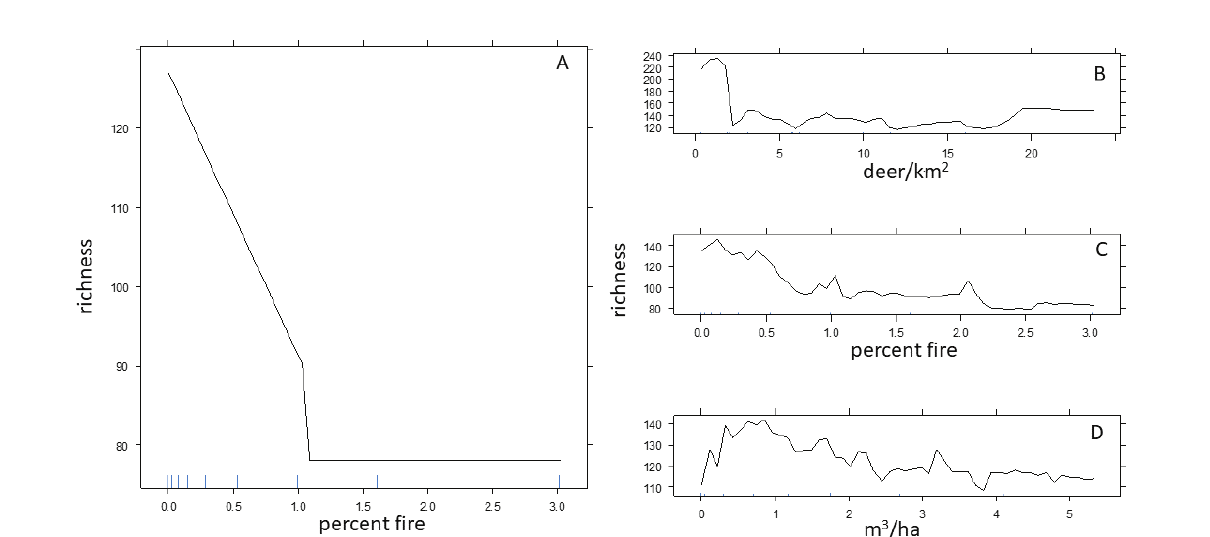
Figure 7. Partial plots that display the strongest modeled relationship in eastern forests between non-native plant richness and percentage wildfire area (A), and in the eastern United States between non-native plant richness and deer density (B), percentage wildfire area (C), and tree removals (D). Additional x-axis tick marks indicate the deciles of the predictor distributions.